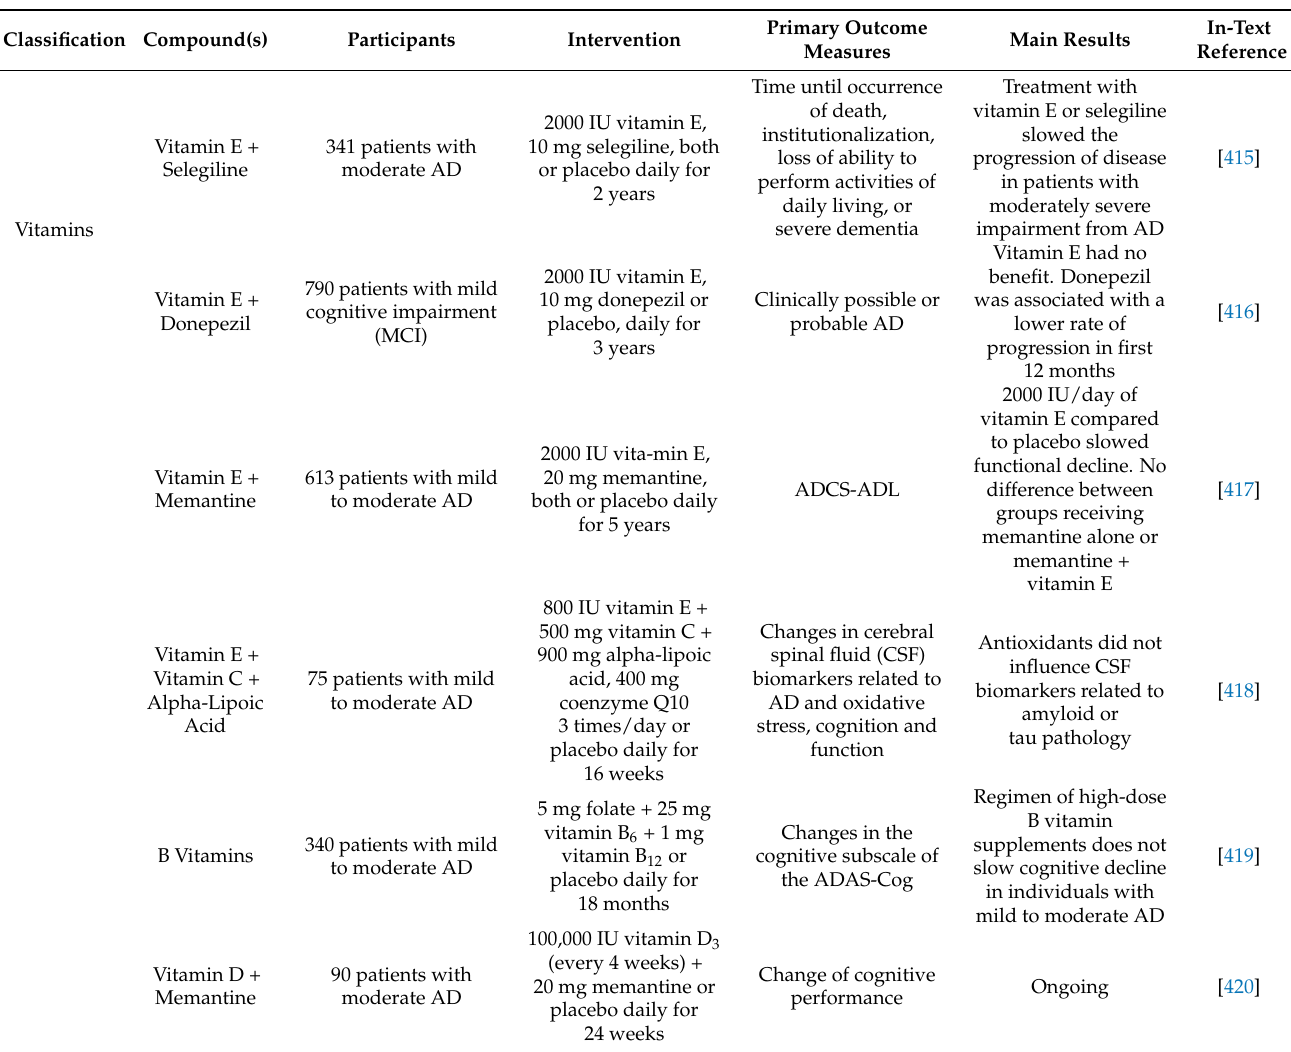
Table 2. Summary of clinical trials utilizing combination/conjugate antioxidants as preventative therapy or treatment in AD. ADCS-ADL: Alzheimer’s Disease Cooperative Study—Activity of Daily Living; ADAS-Cog: Alzheimer’s Disease Assessment Scale (Cog: Cognitive score).